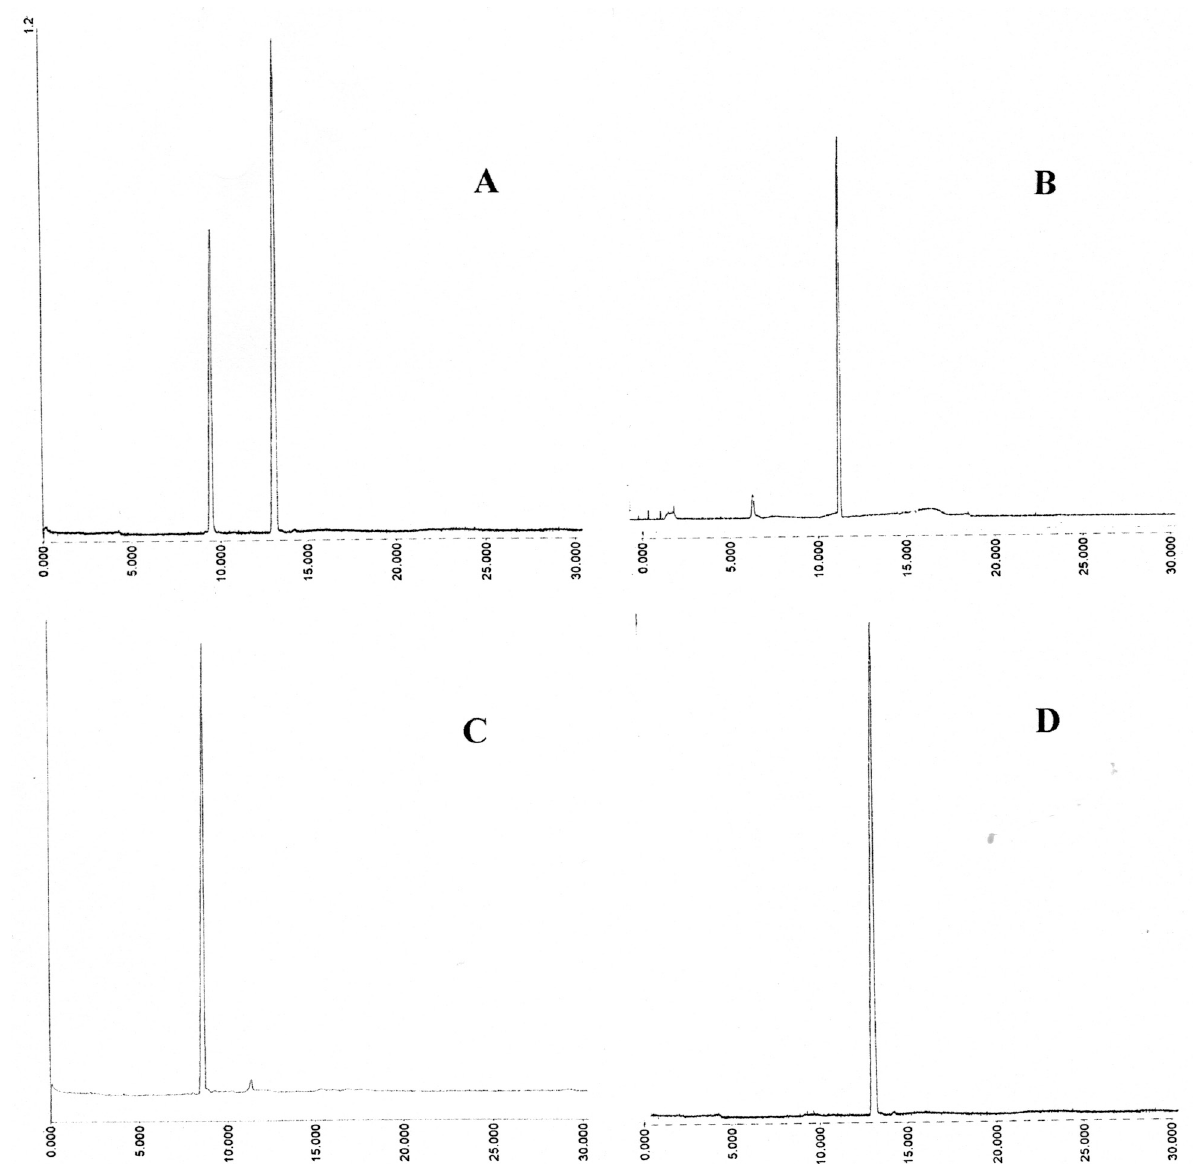
Figure 3. Capillary electrophoresis of aromatic mixed disulfides isolated on DE52. Instrument: Crystal CE310 (ATI Unicam) capillary; length 65 cm, ID 75 µ m; UV detector; Unicam 4225 set at 325 nm; Buffer; 30 mM sodium phosphate pH 7.6 containing 5% isopropanol; Applied voltage 20 kV; Temperature 25 °C; Injection of sample; 0.2 min at 20 mB pressure. (A) GSSE (left) and ESSE (right); (B) 12.5 mS peak; (C) 15.1 mS peak; (D) 25.2 mS